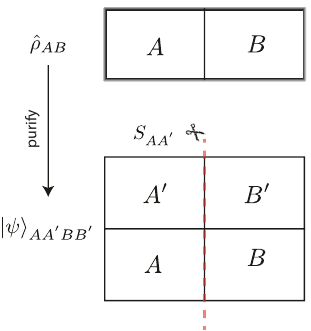
Figure 1. Illustration of the de(cid:12)nition of the entanglement of